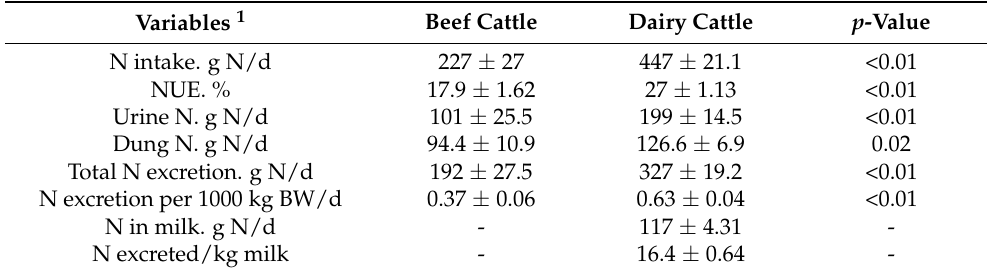
Table 4. Nitrogen intake and its partitioning into product, urine and dung (mean ± standard error) of dairy and beef cattle in Chile. Variables 1 Beef Cattle Dairy Cattle p